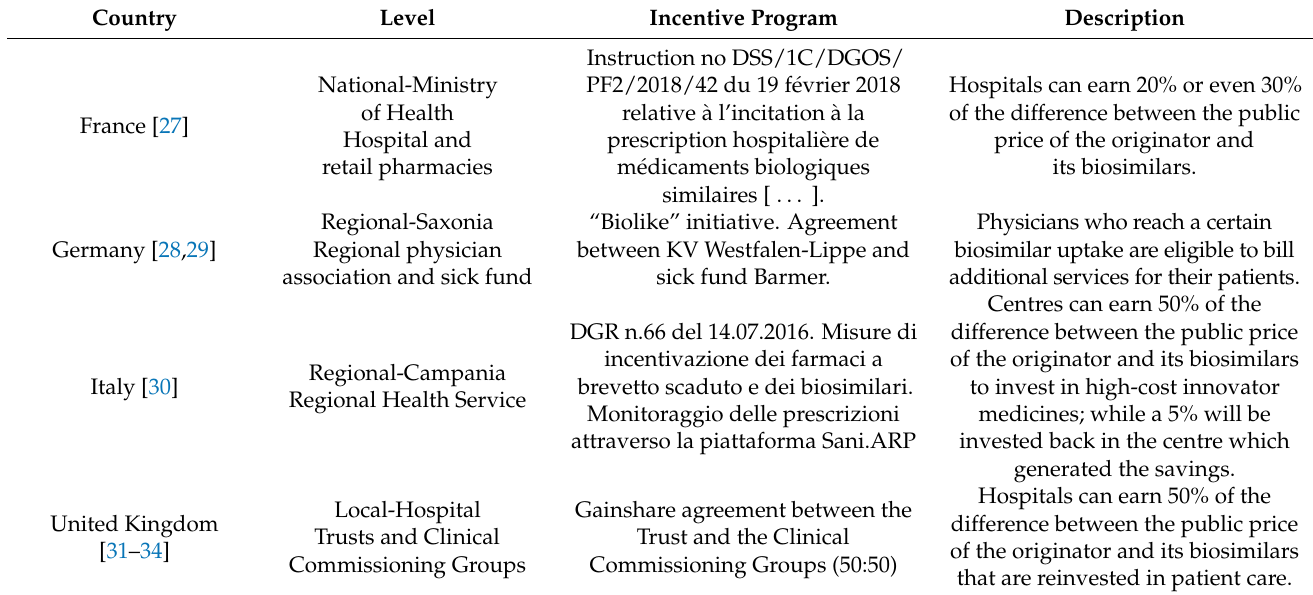
Table 1. European initiatives on biosimilar prescribing